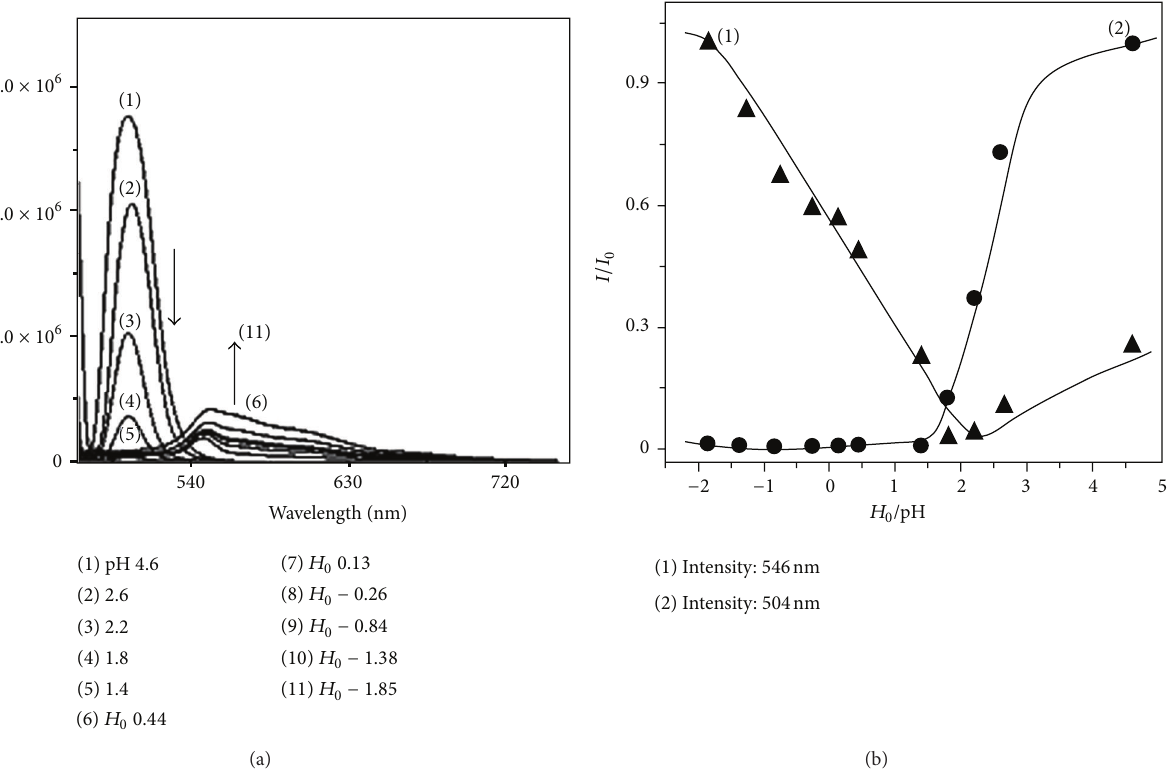
Figure 9: (a) Fluorescence spectra of C334 at various pH in water. (b) 𝐼/𝐼 0 versus 𝐻 0 /pH plot of C334 in